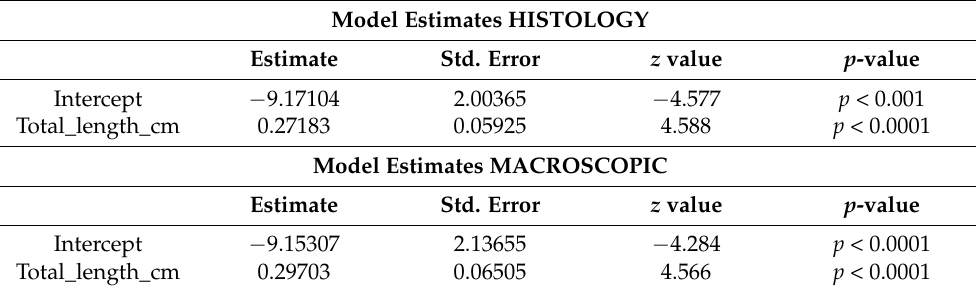
Table 2. Summary of the L50 estimates based on histological and macroscopic